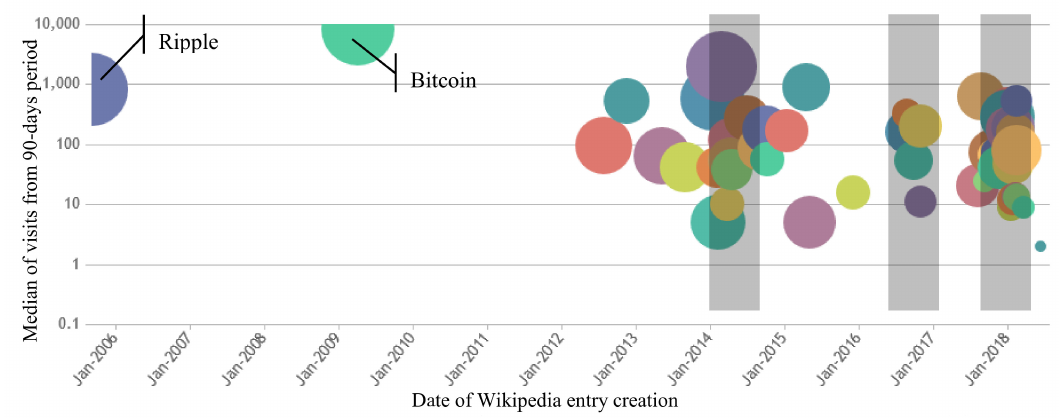
Figure 2. Popularity of cryptocurrencies on English (EN) Wikipedia and the timeline of the article creation